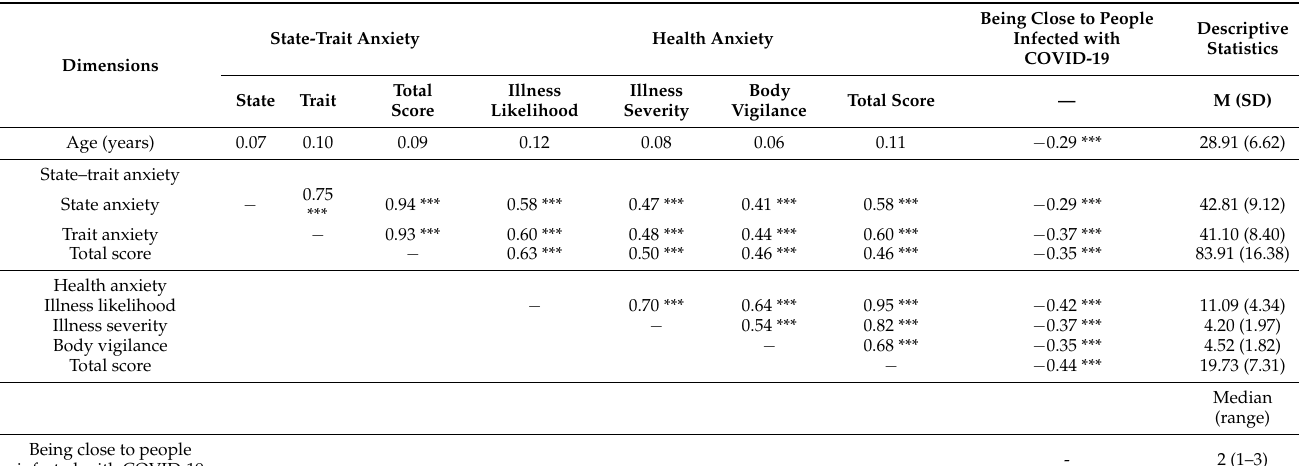
Table 2. Descriptive and correlational statistical indices (Pearson’s correlations) of age, state and trait anxiety, health anxiety, and being close to people infected with COVID-19 (Spearman rank correlations).